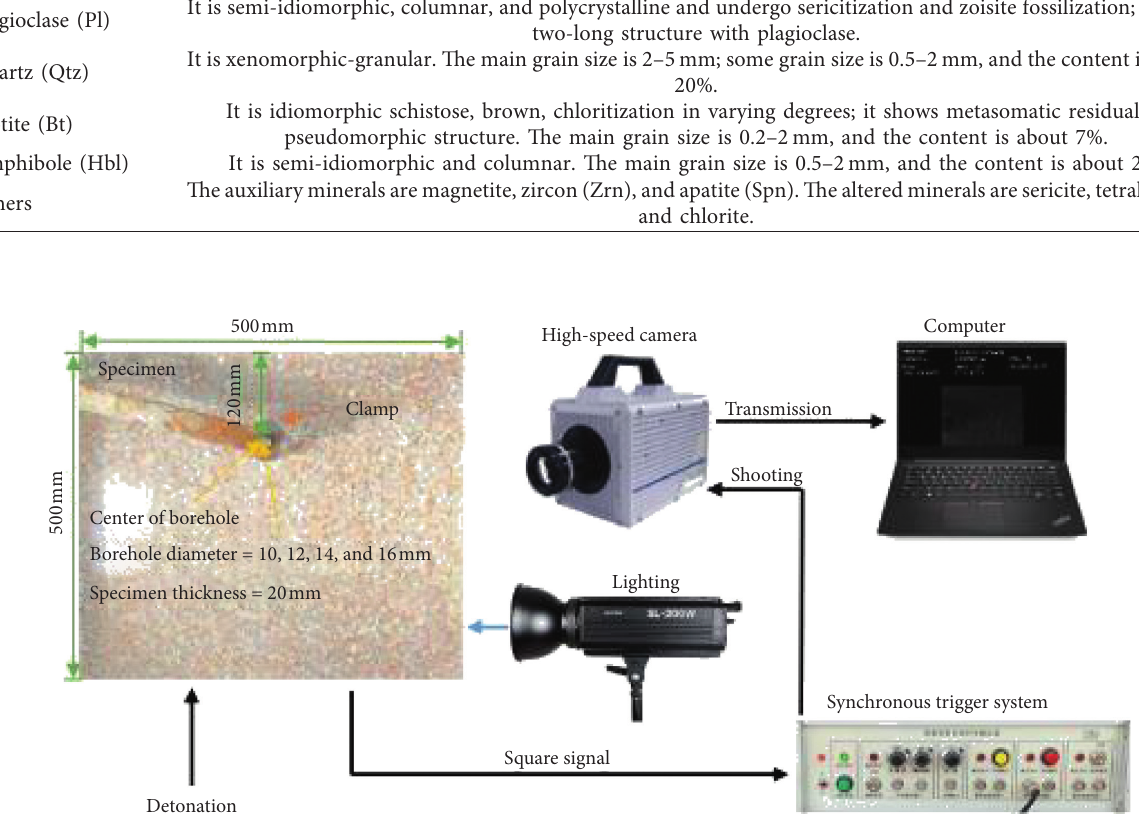
Figure 2: Experimental system of the high-speed digital image